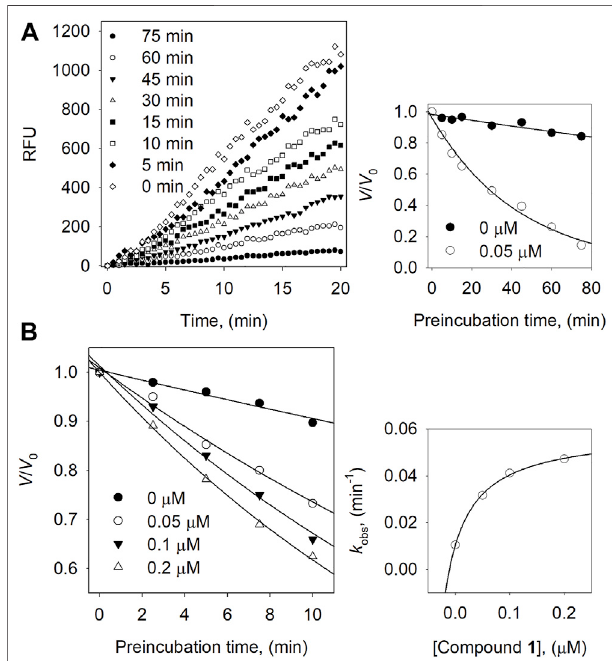
FIGURE3|(A) Slow-bindinginhibitionatdifferentpreincubationtime( ◇ : 0; ◆ : 5; □ : 10; ■ : 15; △ : 30; ▼ : 45; ○ : 60; C : 75 min) for compound 1 at 0.05 μ M. Inset: Inhibition as a function of preincubation time for compound 1 . (B) Time course of the inactivation of BNA compound 1 . Inset: plot of k obs on the dependence on different concentrations of compound 1